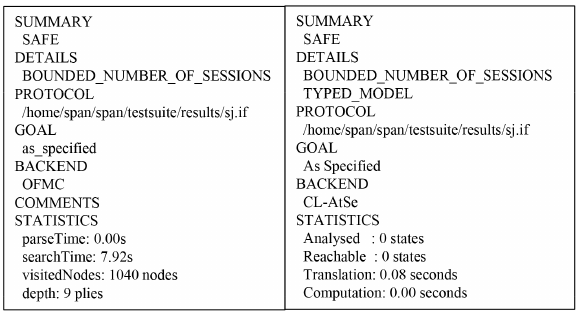
Figure 13. Analysis of AVISPA simulation using OFMC and